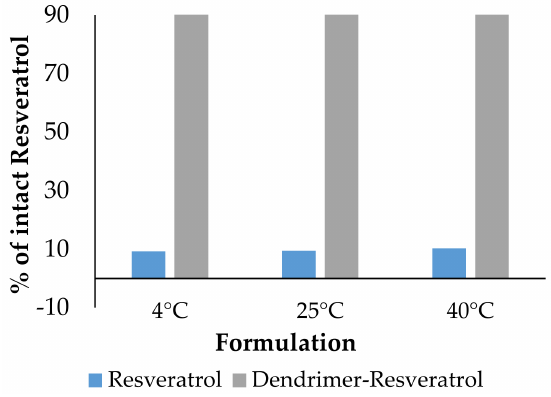
Figure 4. Percentage of intact resveratrol remaining in the formulations after Day